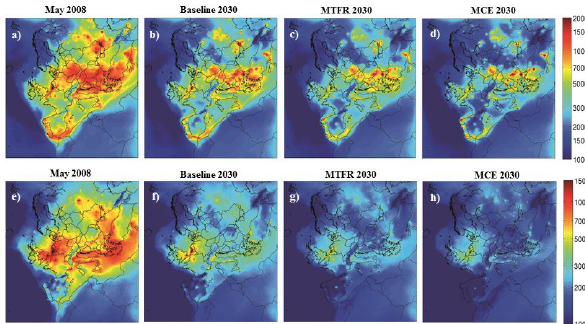
Fig. 3. Model simulations for 2008 and the baseline, MTFR, and Fig. 3: Model simulations for 2008 and the baseline, MTFR, and MCE scenarios for 2030 for 981 MCE scenarios for 2030 for N tot (a–d) , and N 100 (e–h) . The con- N tot (a-d), and N 100 (e-h). The concentrations are median values in each grid cell for the whole 982 simulation period. The colour bars indicate particle number concentration in # cm -3 . 983 centrations are median values in each grid cell for the whole simula- tion period. The colour bars indicate particle number concentration in # cm − 3